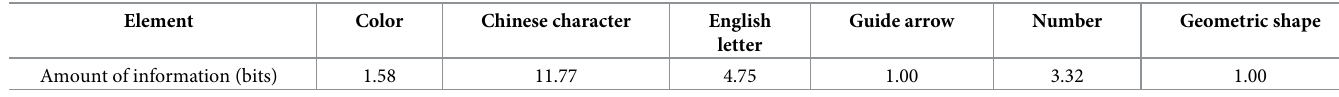
Table 3. Information contained by each element of highway exit advance guide